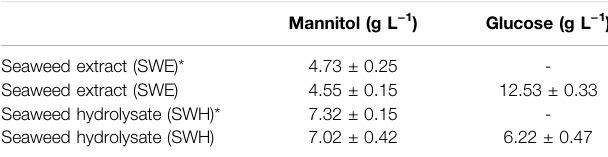
TABLE5| Mannitolandglucoseconcentrationsintheseaweedextract(SWE)and seaweed hydrolysate (SWH) used in this work.